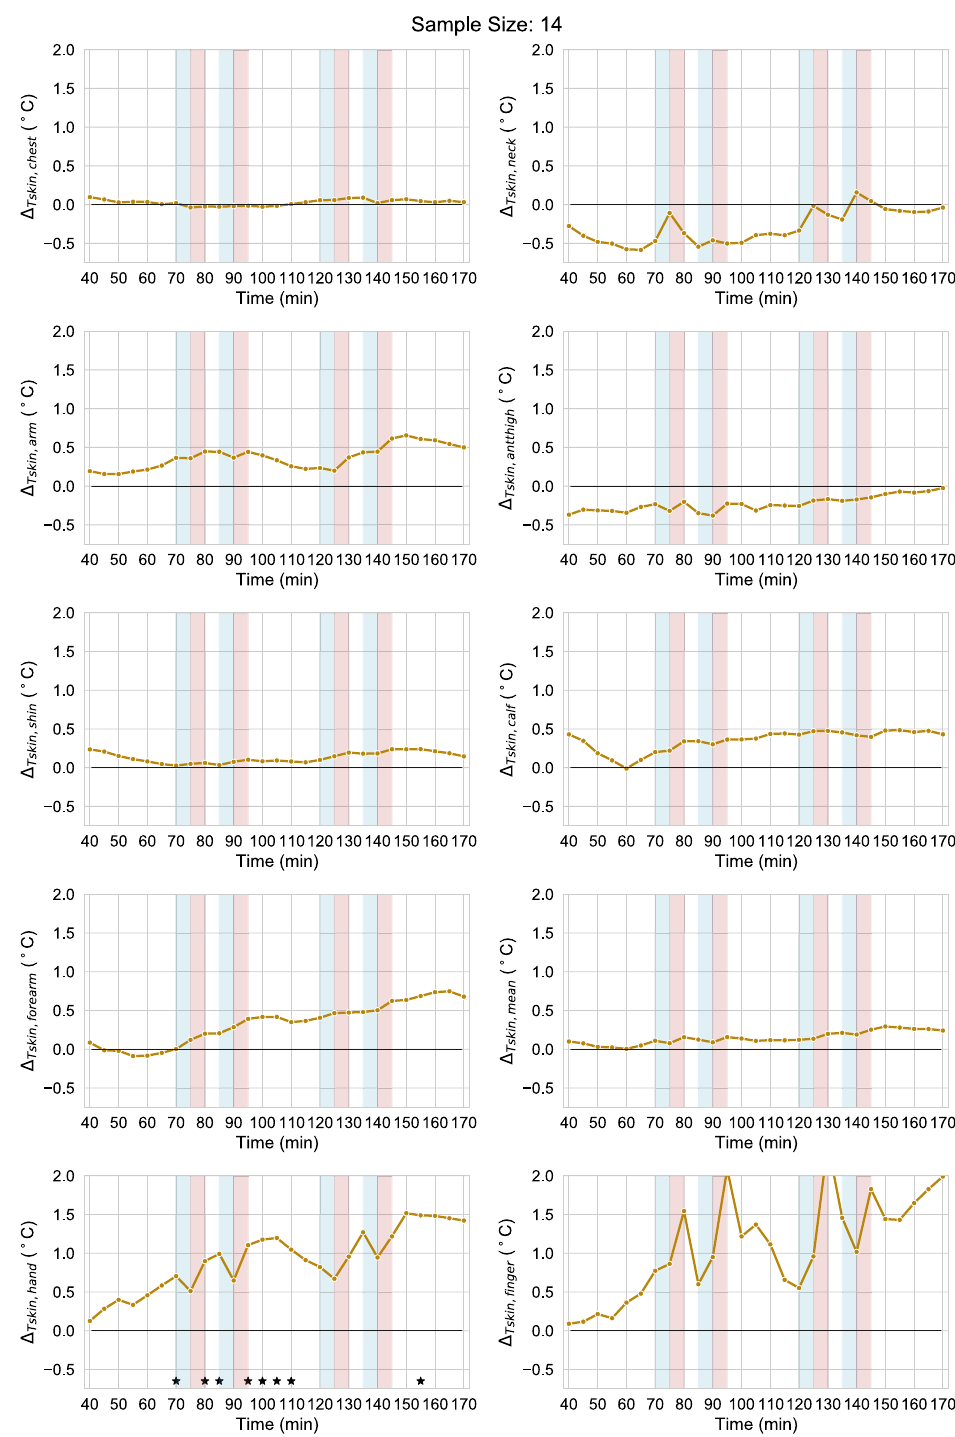
Figure 7. Mean difference (Δ) between male and female values of the skin temperature at different locations. Asterisks indicate statistically significant